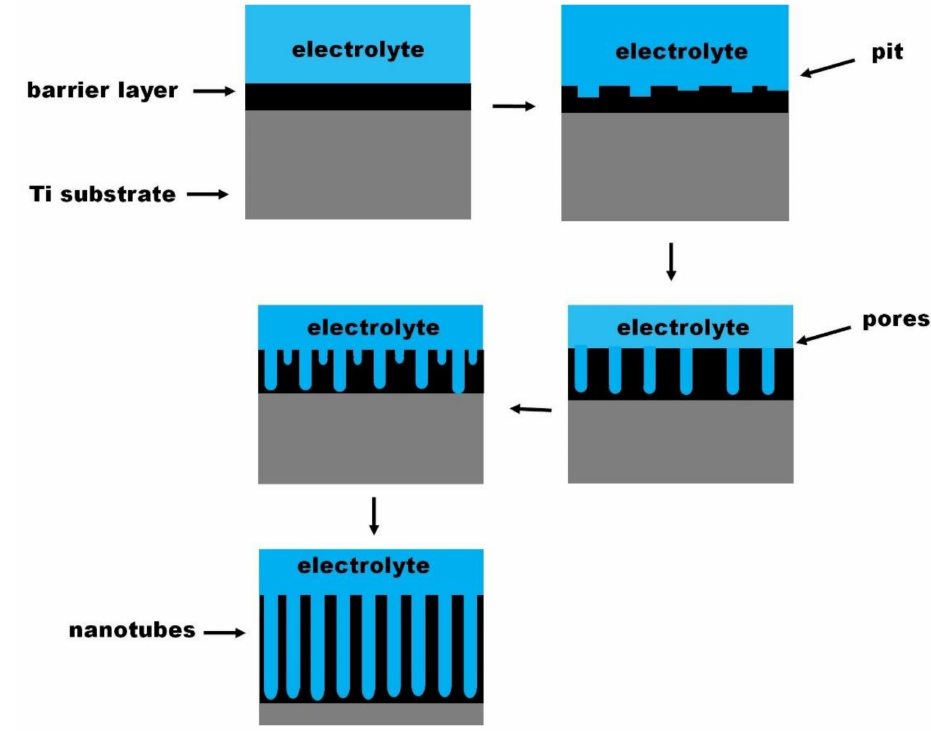
Figure 6. Scheme presenting the stages of TNTs formation by field-assisted